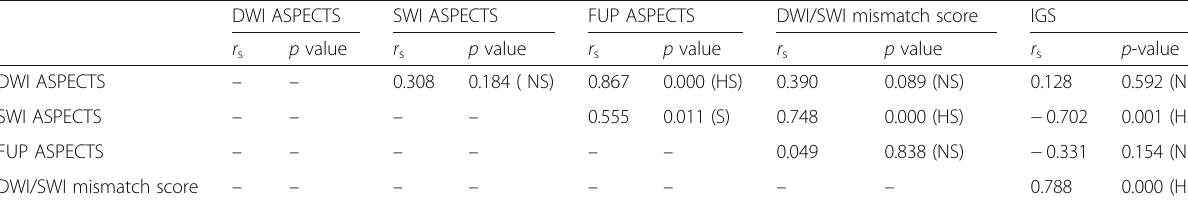
Table 6 Correlations between the various scores and their statistical